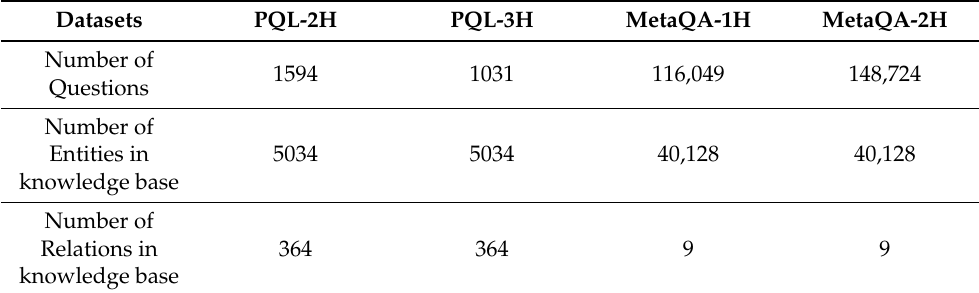
Table 2. Statistics of the hypergraph datasets used in the